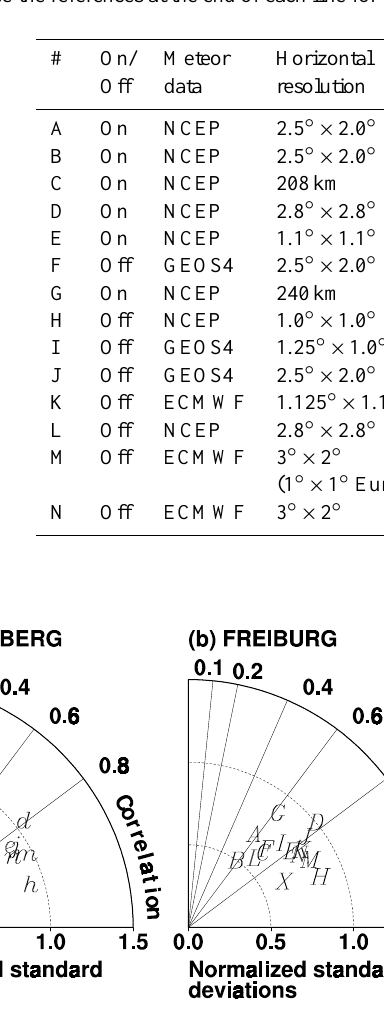
Table 1. List of participating models with selected properties. On/Off indicates that the model is run with the calculation of wind fields (On) or without them (Off). Meteorological data set to drive transport is indicated in the abbreviation of the organization which produced the data set. Horizontal resolution is shown either in degrees or length. Vertical levels are indicated with number of levels and the type of coordinates; σ indicates that the vertical levels are defined with the ratio of pressure at the level and a reference. η is for hybrid of pressure and σ . “z” indicates the vertical levels are altitude without temporal variations. See Law et al. (2008) for organizations which provided output. Also see the references at the end of each line for details.